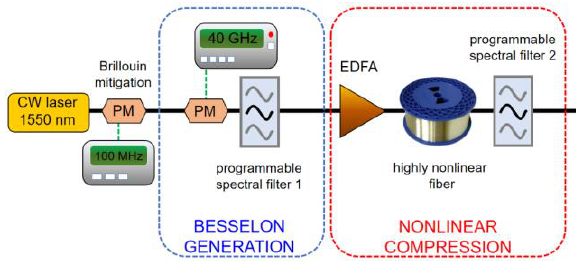
Fig. 1. Experimental